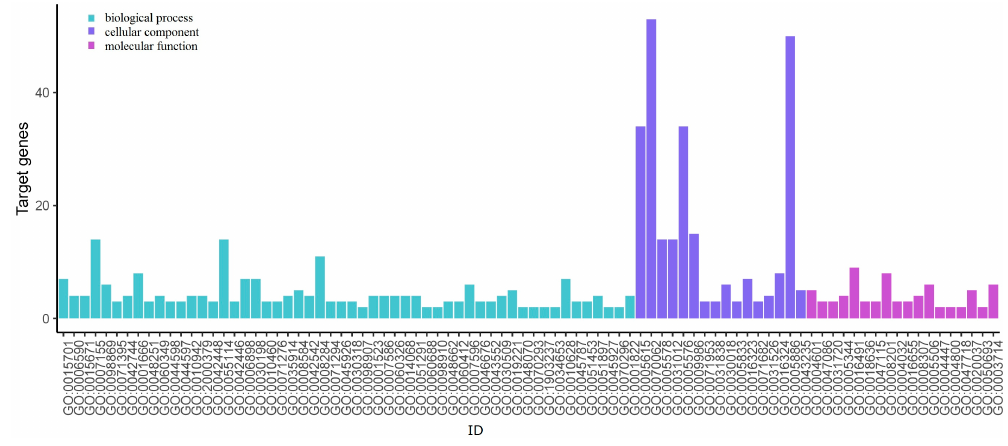
Figure 5. Up-regulated genes Gene Ontology (GO) enrichment analysis.